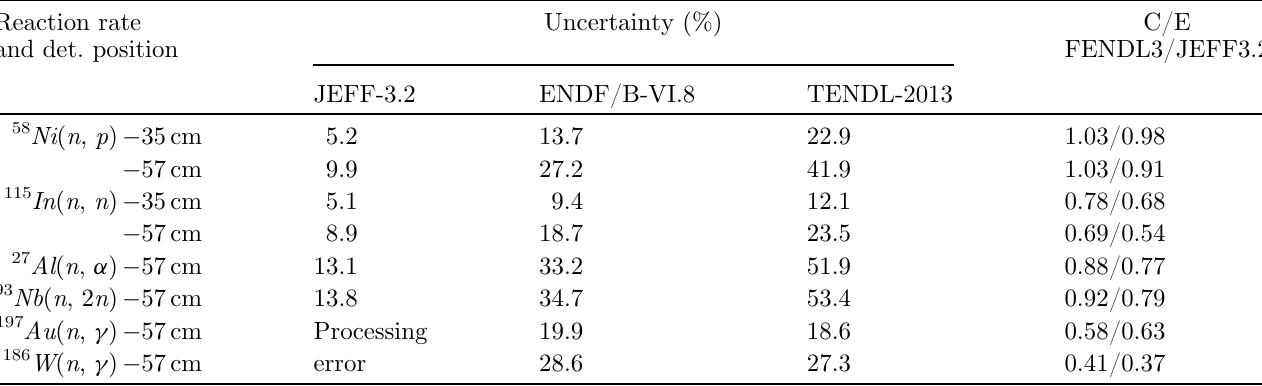
Table 2. FNG-Cu benchmark: uncertainty due to transport cross-sections of different origin compared to the C/E values. Reaction rate and det. position